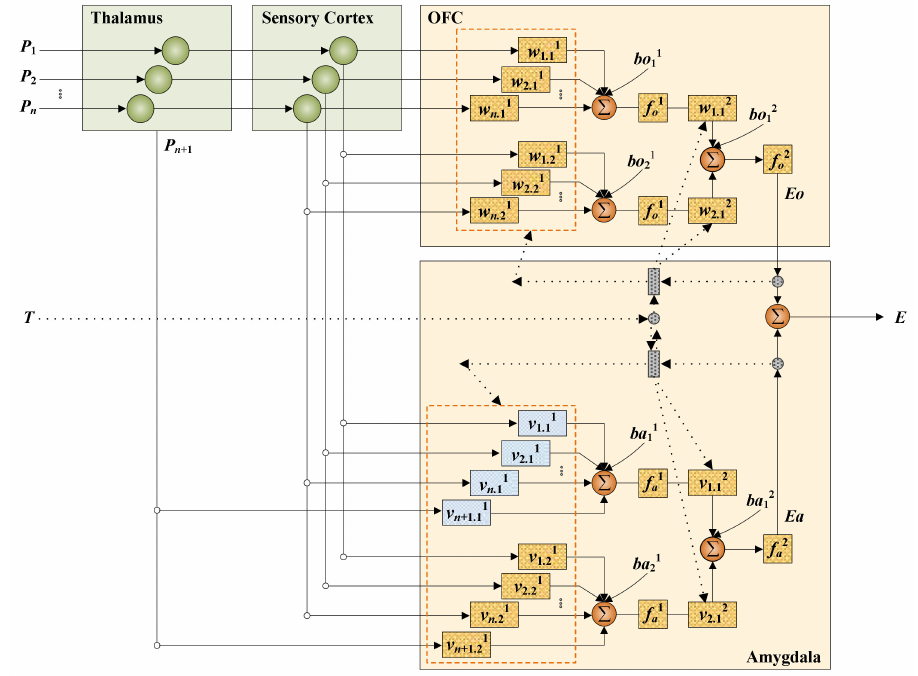
Figure 2. Limbic-based artificial emotional neural network (LiAENN)